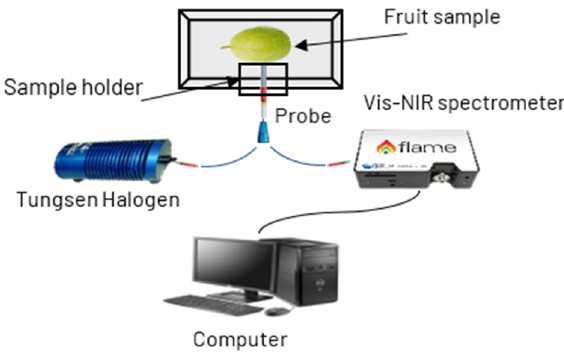
Figure 1: Spectra acquisition set up using Vis – SWNIR